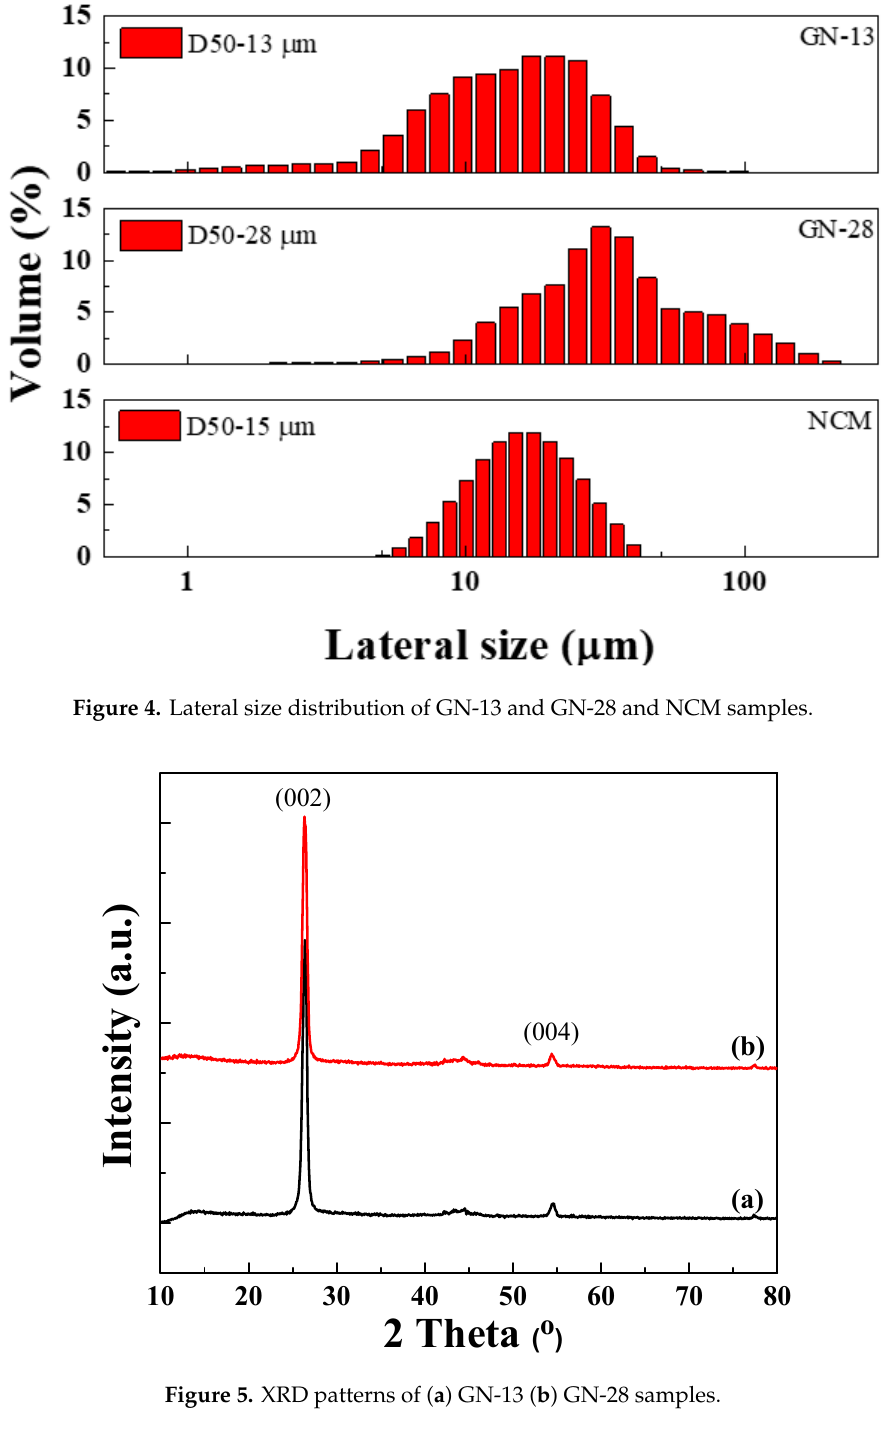
Figure 3. AFM images of different graphene sheet sizes and distribution of thickness of ( a ) GN-13 and ( b ) GN-28 with 30 samples.